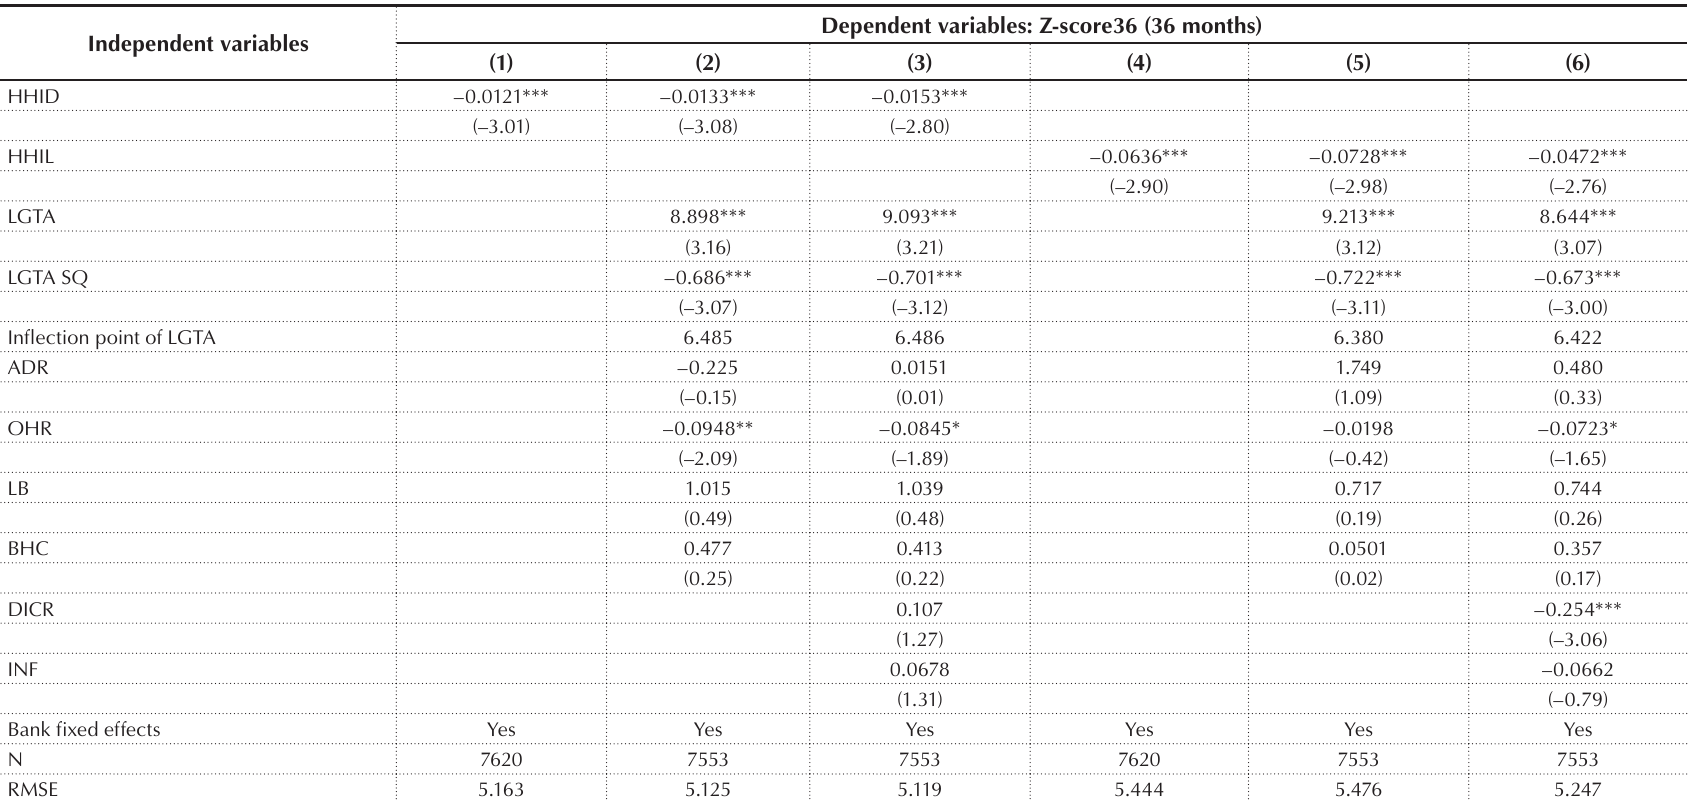
Panel B. Second-stage IV regression